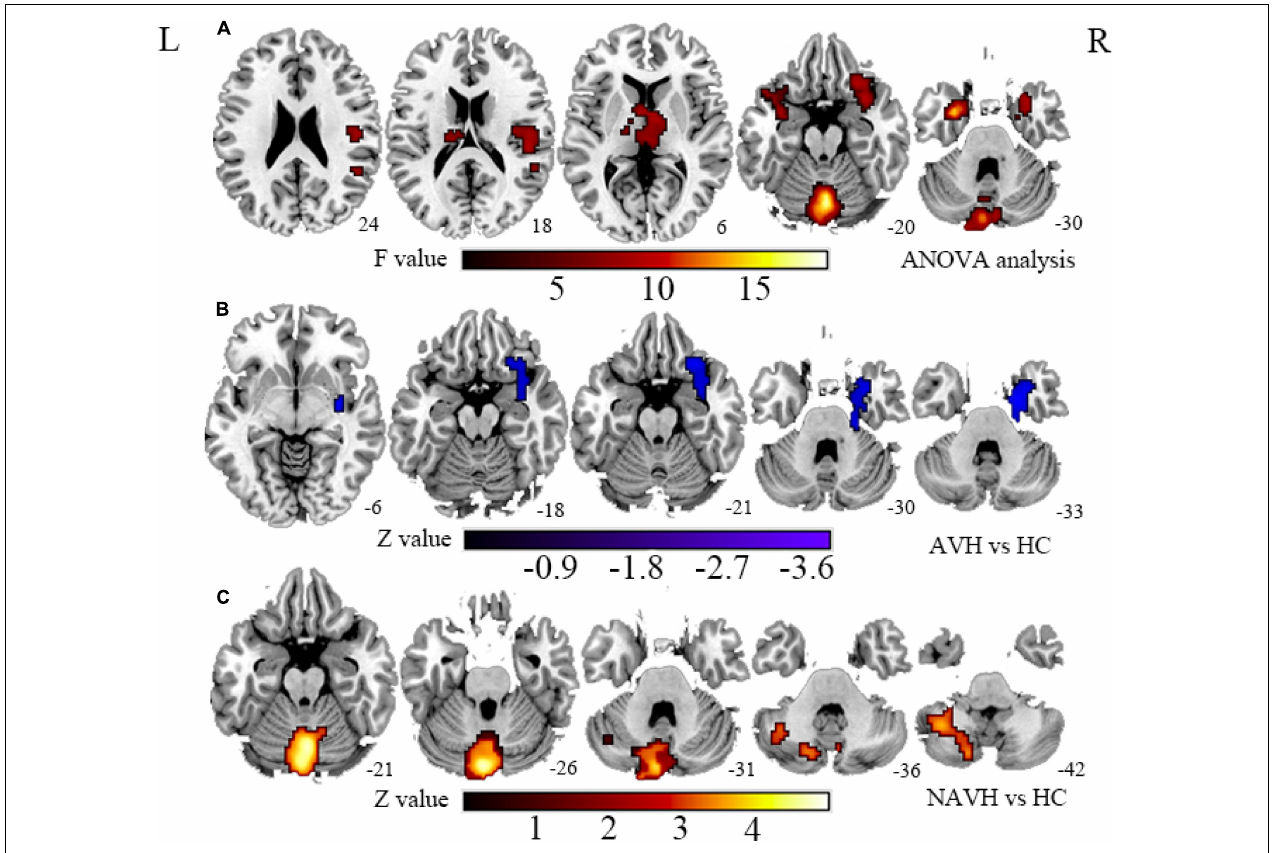
FIGURE 2 | (A) Brain regions with significant FCS changes between AVH, NAVH, and HC groups. (B) Brain regions with significant FCS changes in the AVH group. (C) Brain regions with significant FCS changes in the NAVH group. FCS, functional connectivity strength; AVH, schizophrenia patients with AVHs; NAVH, schizophrenia patients without